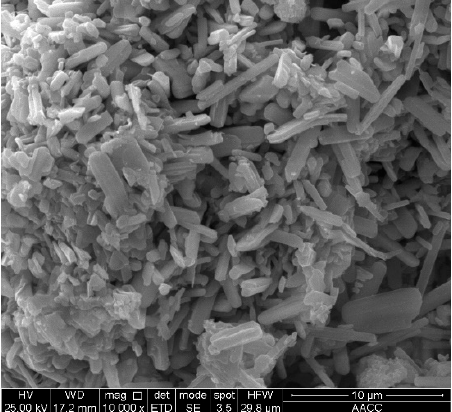
Figure 1. Scanning Electron Microscope (SEM) images of lamellar ZrS 2 nanobelts.